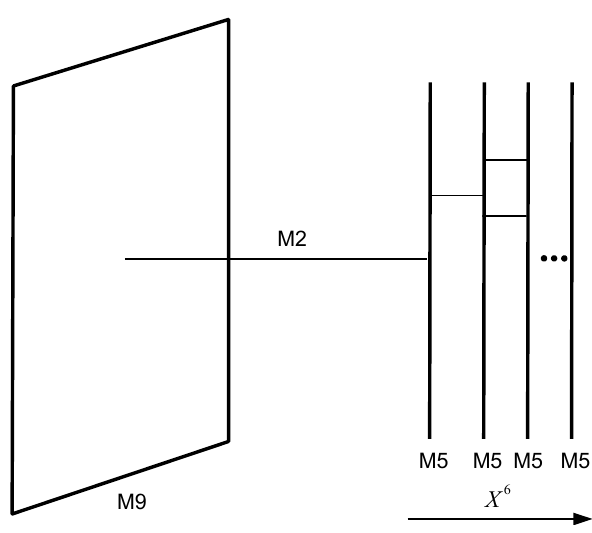
Figure 5 . E-strings as suspended M2 branes between M5 branes probing an M9